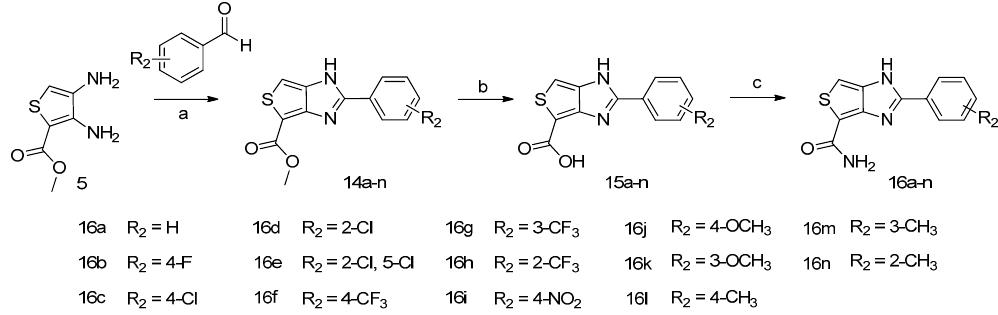
Compd. R 1 IC 50 ( μ M) Compd. R 1 IC 50 ( µ M) Olaparib 0.018